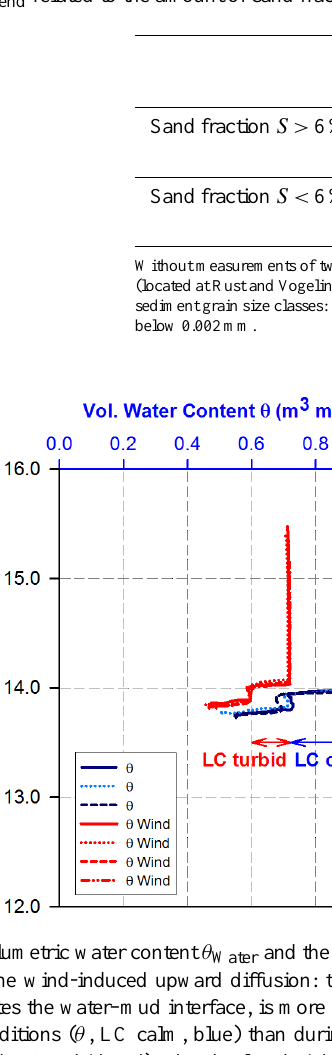
Table 1. θ HP end related to the amount of sand fraction at the open water.